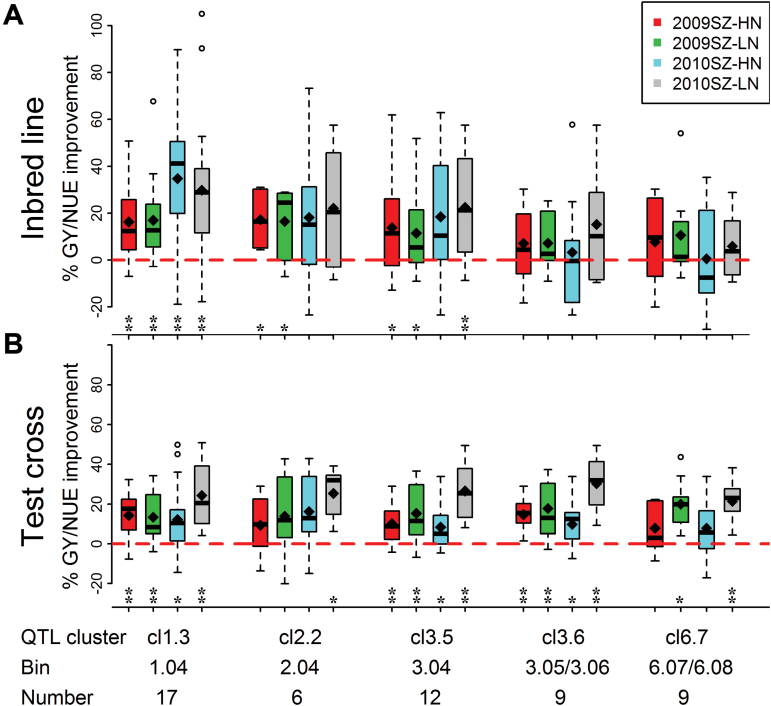
Validation of QTL cluster using the performance of an advanced backcross population at (A) per se and (B) testcross evaluation. The difference of GY and NUE (GY/NUE) between each ABL and the recurrent parent Wu312 was estimated by grain improvement (%),calculated as (ABL − Wu312)/Wu312. The diamond and black line within the boxplot indicates the mean value and the median value of the ABL, respectively. The bin indicates the genomic location of QTLs on the chromosome. The number of ABLs for each QTL cluster is also presented. A signiﬁcant difference within each environment tested by one-sample t test between the mean and 0 is indicated by an asterisk (*P < 0.05; **P < 0.01).